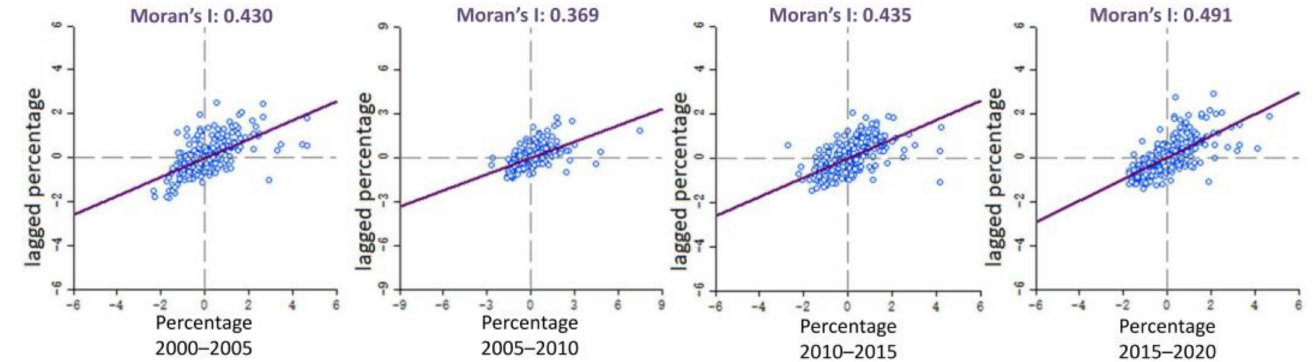
Figure 7. Global Moran’s I of towns.